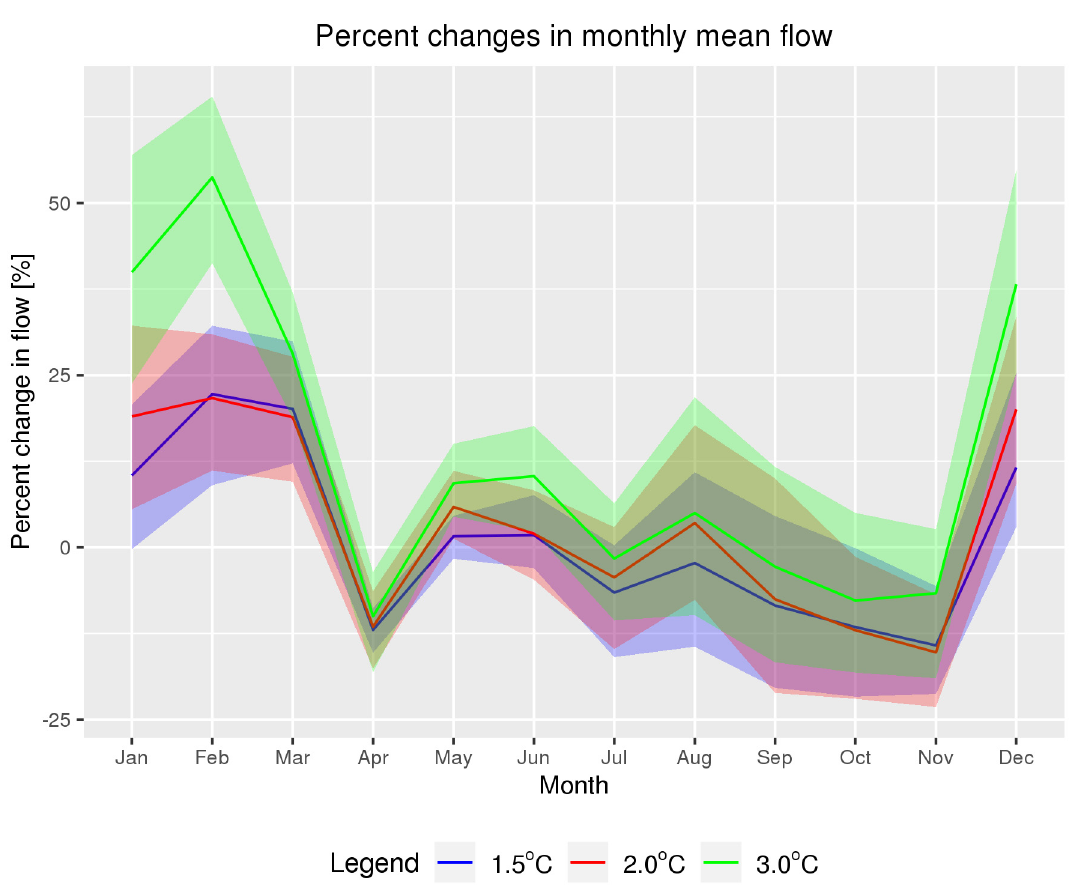
Figure 3. Percent changes in daily mean of monthly streamflow conditions under different levels of temperature increase relative to the base period